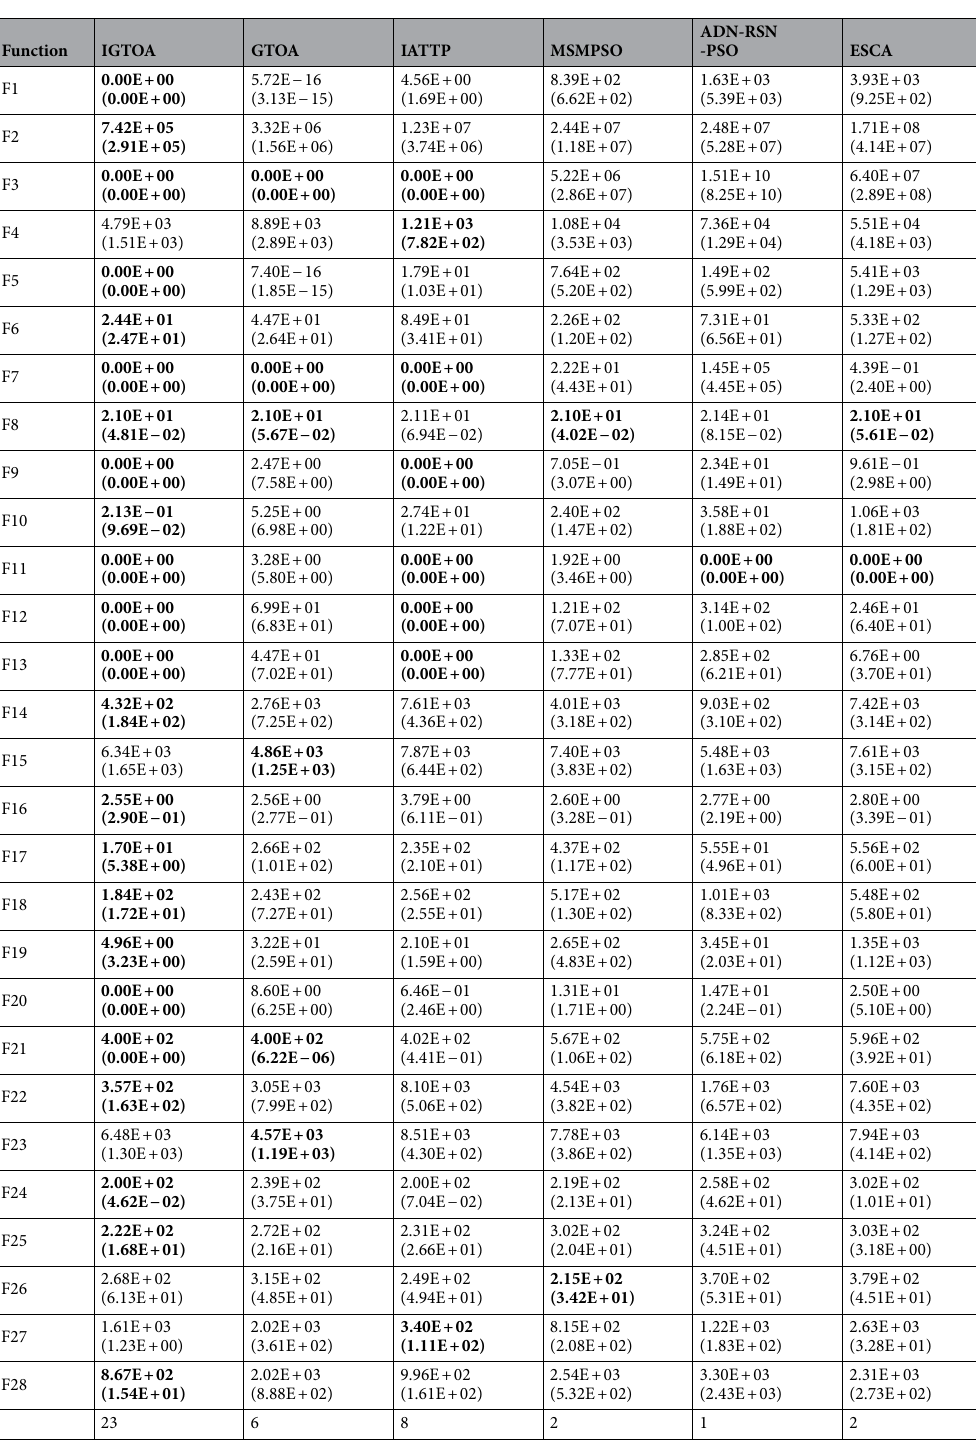
Table 5. Results of each algorithm on the 30-dimensional CEC2013 test set. Note: The parameters that perform best on each function are